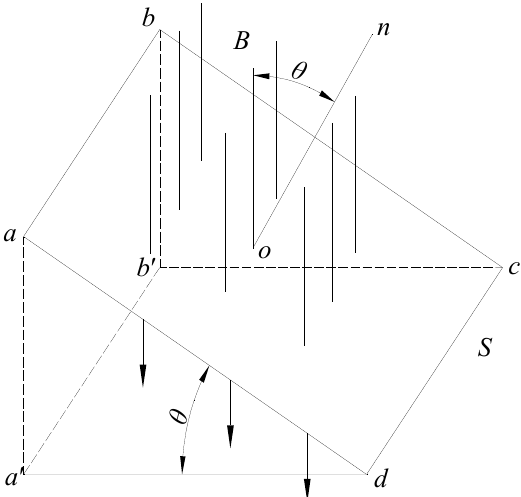
Figure 3. Magnetic flux distribution of a cross-section.